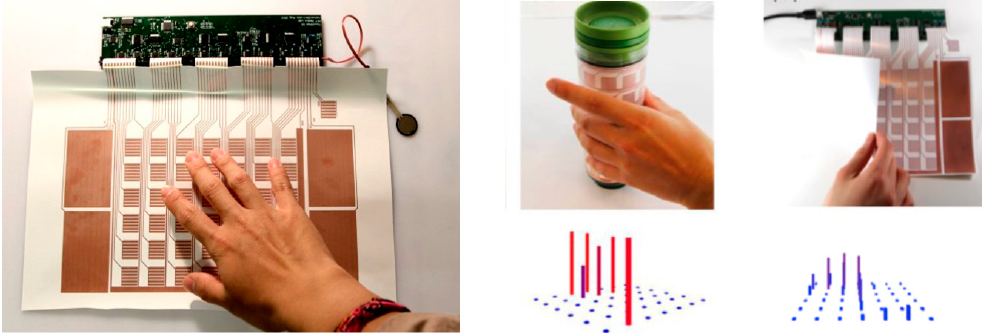
Figure 6. PrintSense: a new development in multi-modal sensing arrays, printed as a single layer on a flexible substrate and connected to a customized hardware module ( left ). Capacitive touch sensing, proximity sensing, galvanic skin response (i.e., resistive sensing) and curved sensing are supported (redrawn from [66]).